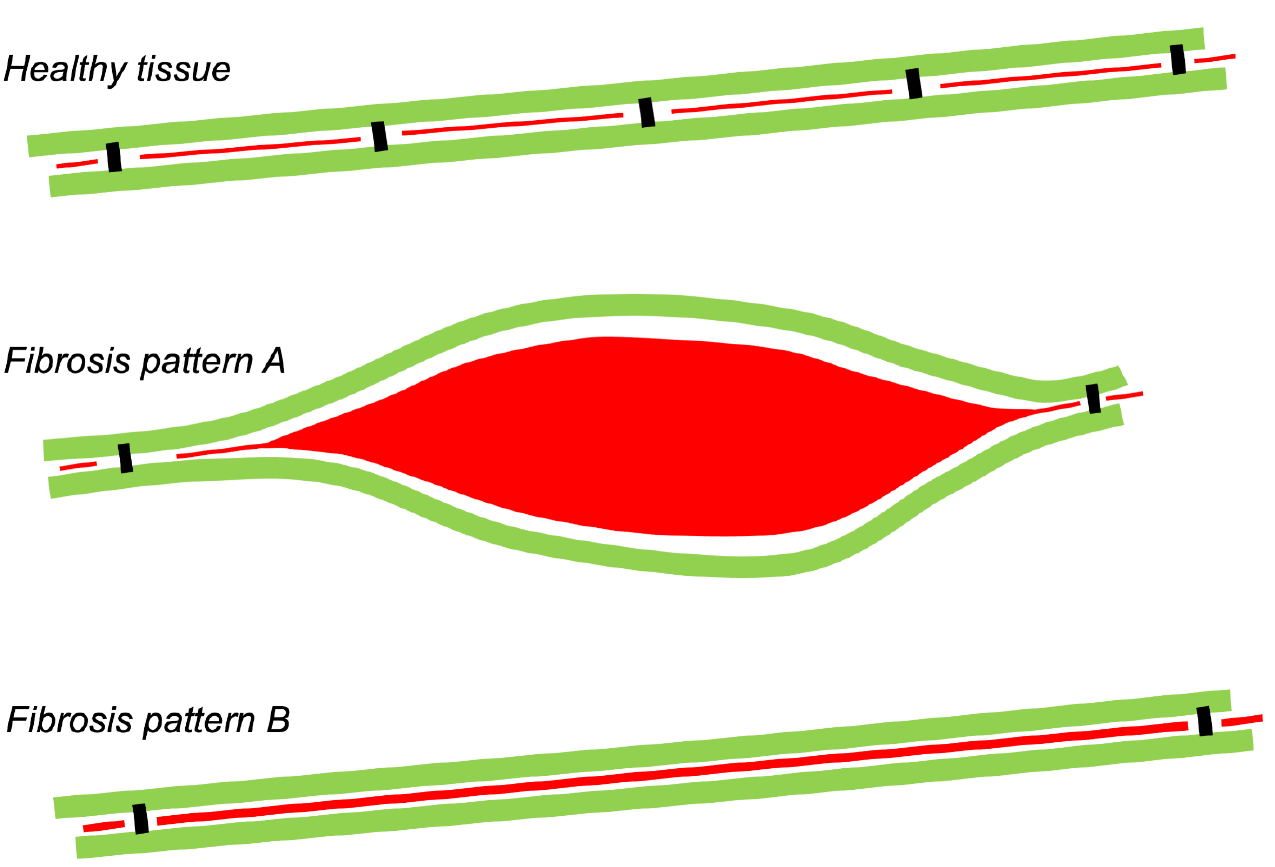
Figure 2. Relation between amount of fibrous tissue and electrical consequences. Conceptual diagram of two strands of longitudinally coupled myocytes (green) connected by sparse, discrete transverse connections (black). In between transverse connections, myocytes are separated by (endomysial) fibrous tissue (red). In fibrosis pattern A, a large area of fibrous tissue separates the strands, and in pattern B, the thickened endomysial septum. Both patterns have reduced transverse connectivity by the same degree, and will therefore have similar consequences for propagation, although pattern B is detected more readily in a histological analysis.